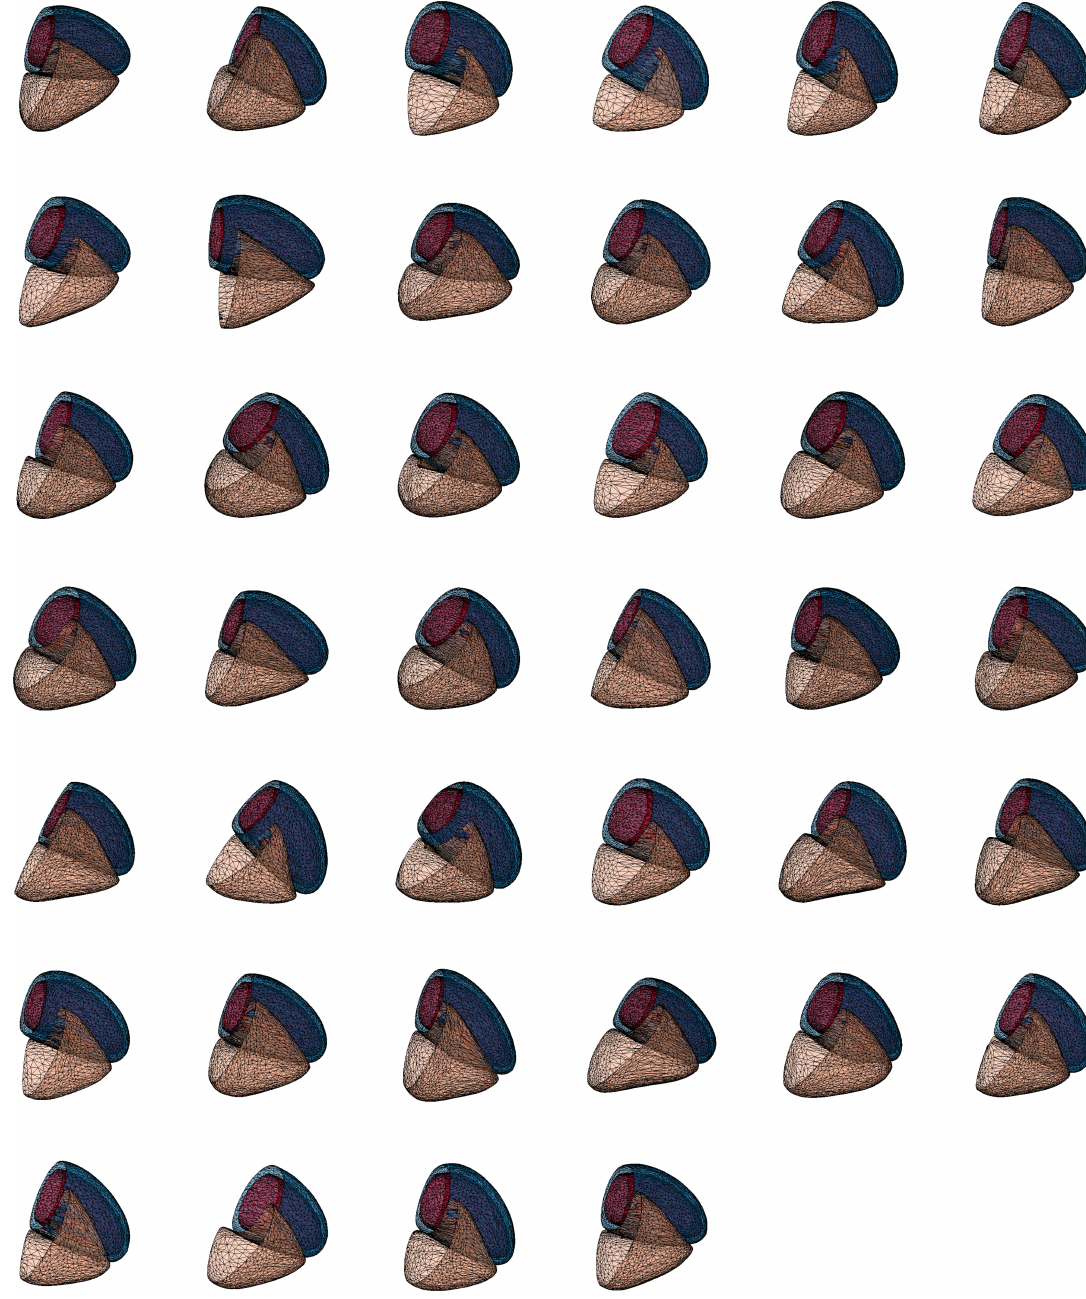
Figure A2. Resulting output mesh using our methodology on simulated CMR acquired contours (see Section 3.1). The figure shows the various shapes of the 40 generated